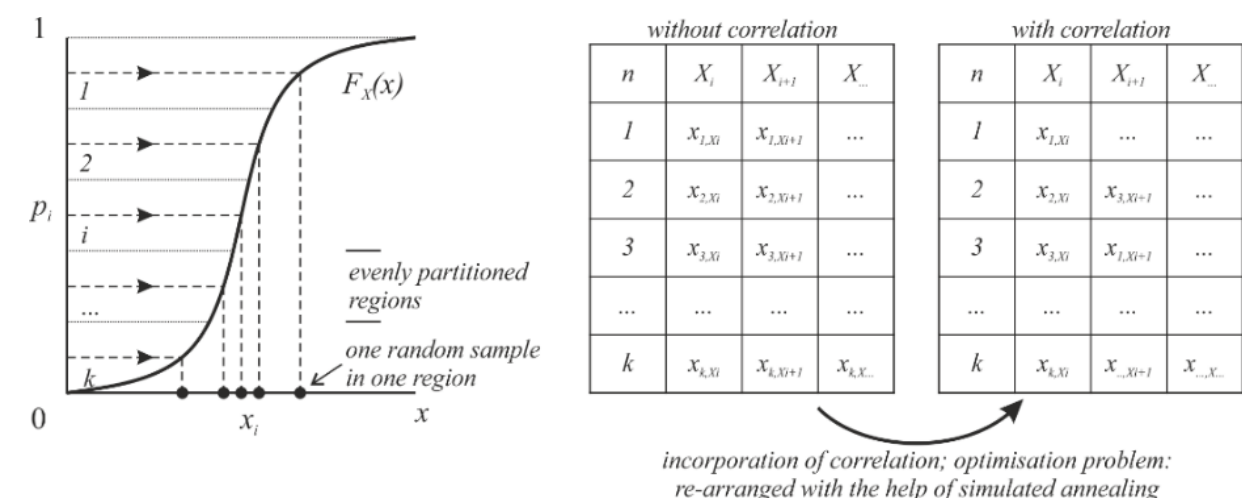
Figure 2. Latin Hyper Cube Simulation (LHS) method including and not including correlation between basic variables.